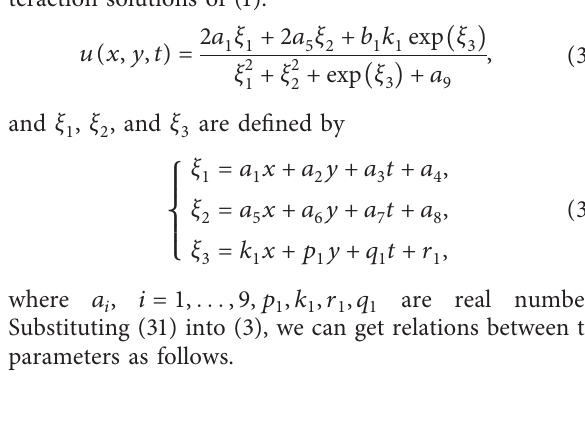
� 1, a � 1, and α � 5 9